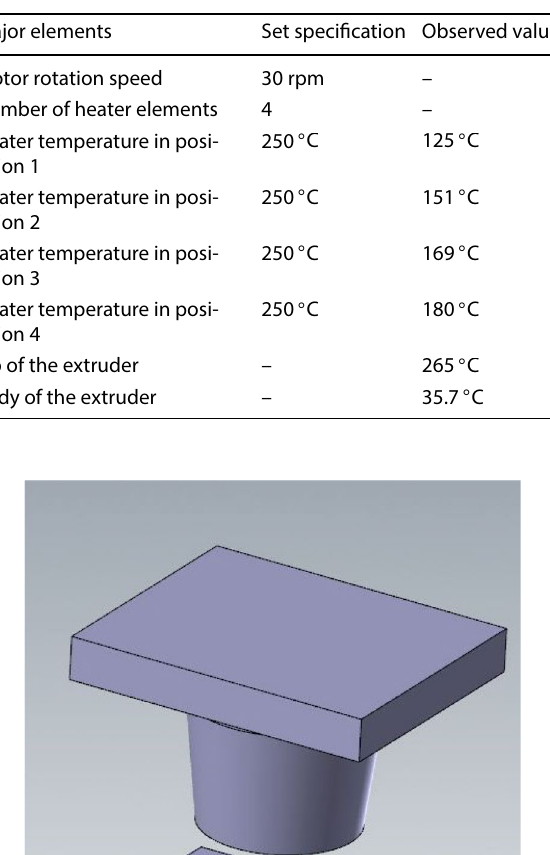
Table 9 Parameters of an extruder with four heater bands